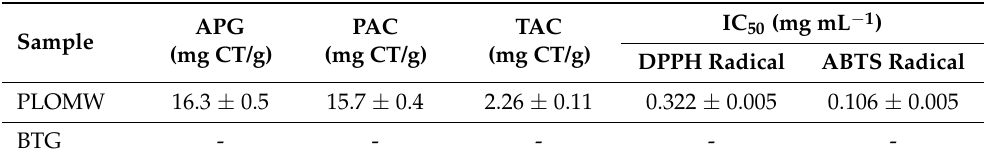
Table 5. Total polyphenols, phenolic acid contents and antioxidant activity of the conjugate polymer. Data represent mean ± RSD ( n =